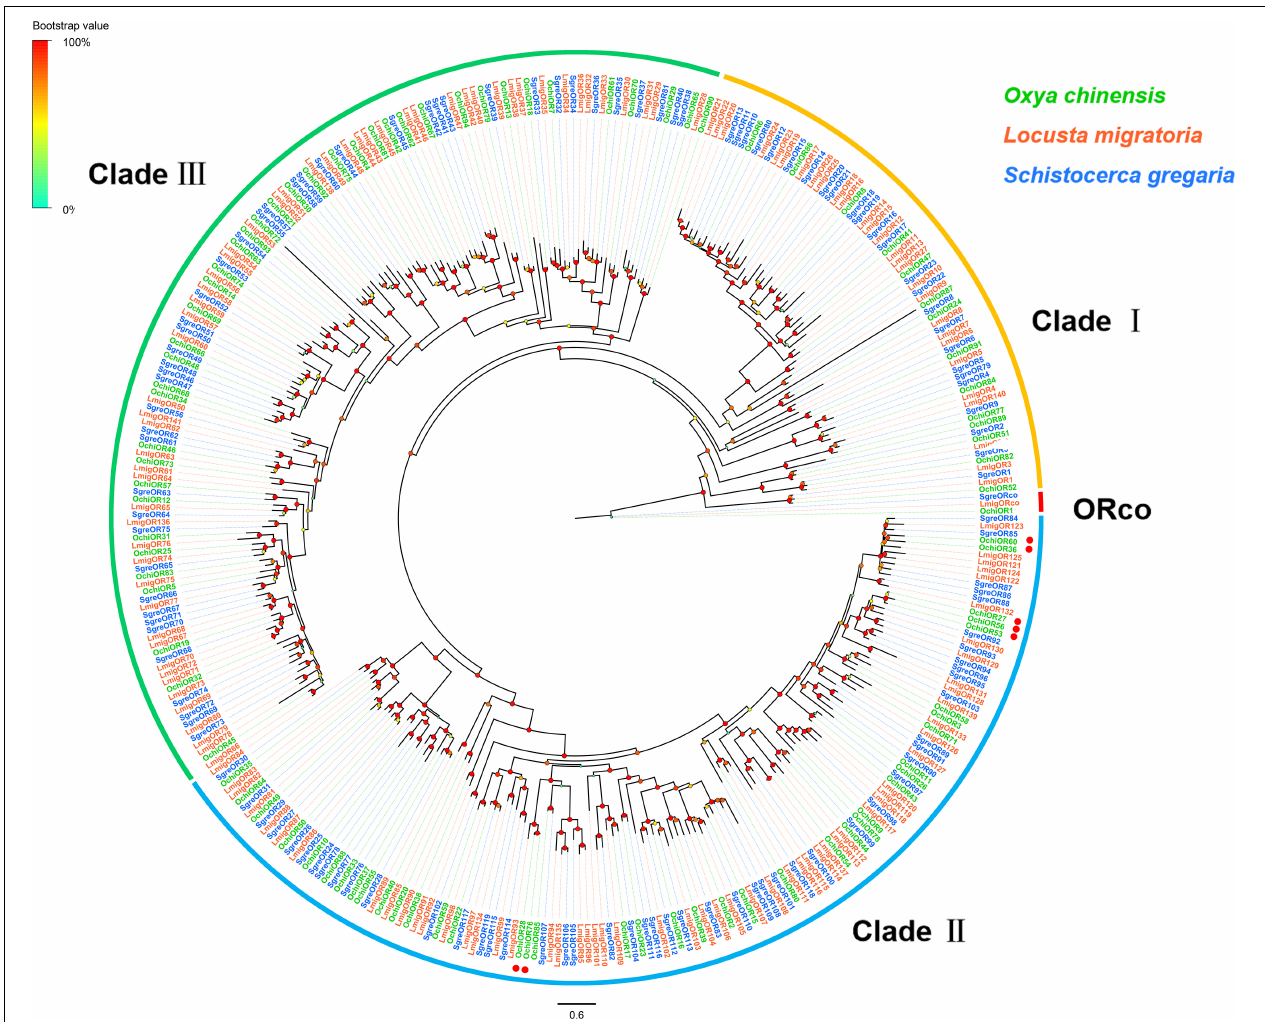
FIGURE 3 | Phylogenetic tree of putative odorant receptors (ORs). The distance tree was rooted by the conservative ORco gene orthologs (red). The species- specific clades and sister pairs are labeled with red dots. Branch support (circles at the branch nodes) was estimated using an approximate likelihood ratio test based on the scale indicated at the top left. Bars indicate branch lengths in proportion to amino acid substitutions per site. The clade I is in orange; clade II in green; and clade III in blue.